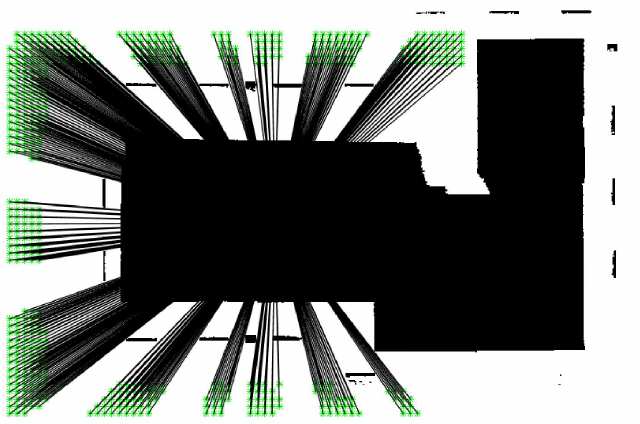
Figure 8. The direction of the viewpoints towards the centre of the building.